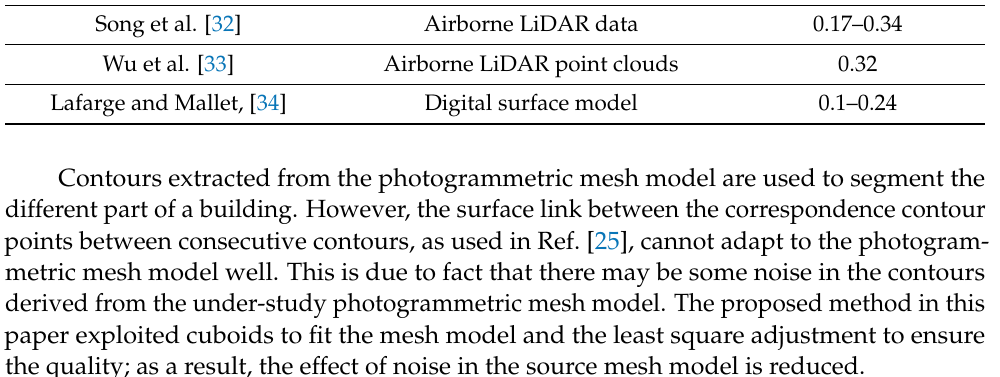
Figure 13. The statistical results of the reconstruction errors for a scene.